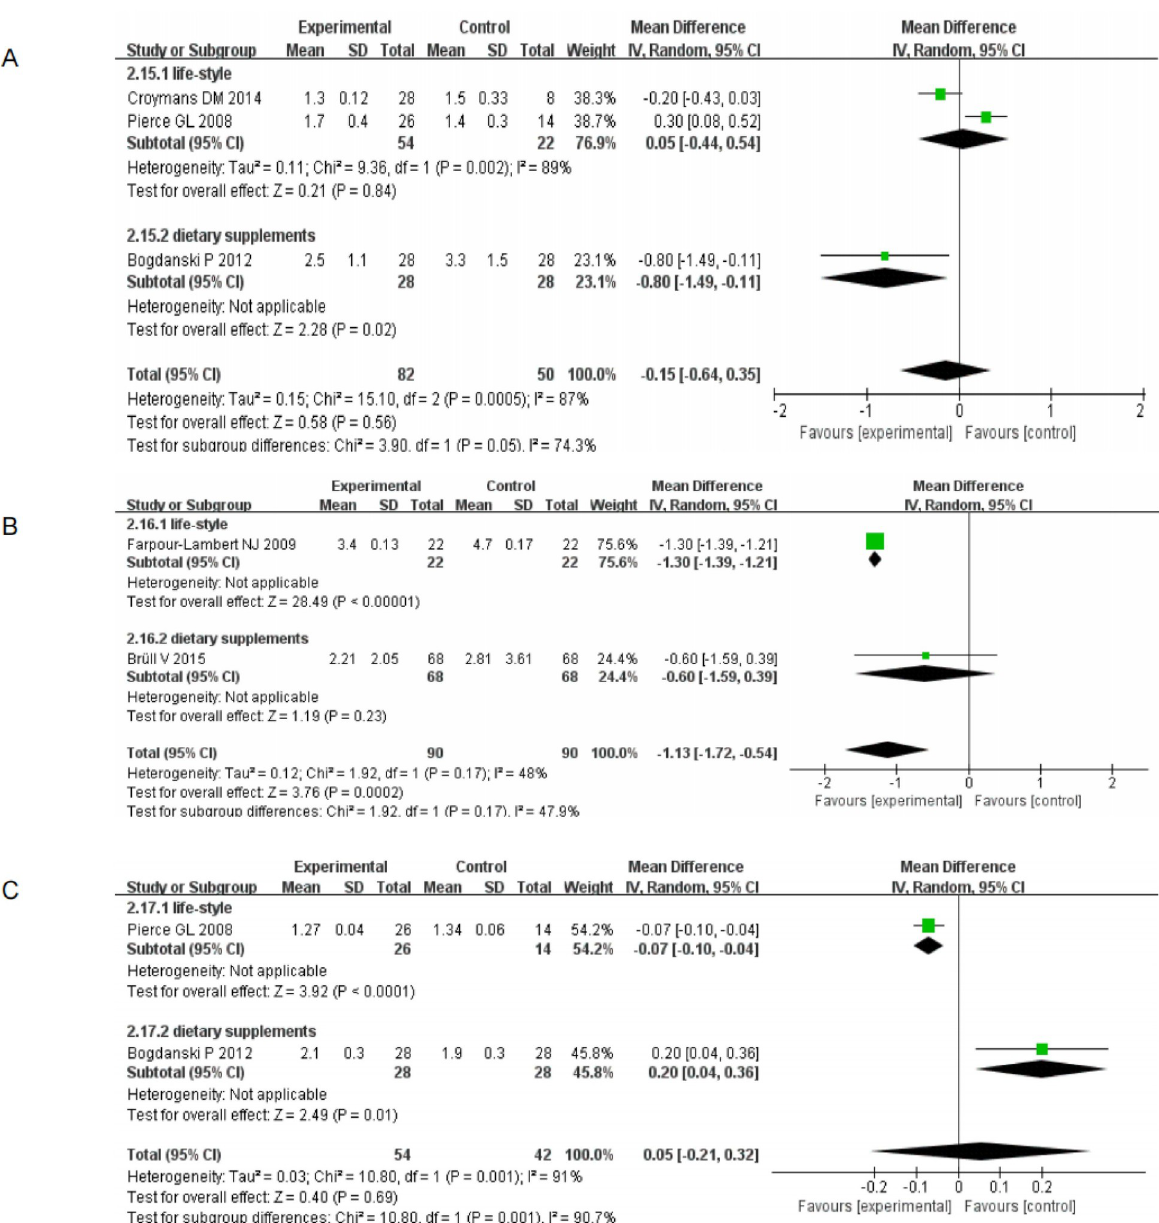
Fig 7. Forest map secondary outcome indicators (A) CRP Forest map secondary outcome indicators (B) hs-CRP Forest map secondary outcome indicators (C) TAS Forest map secondary outcome indicators.